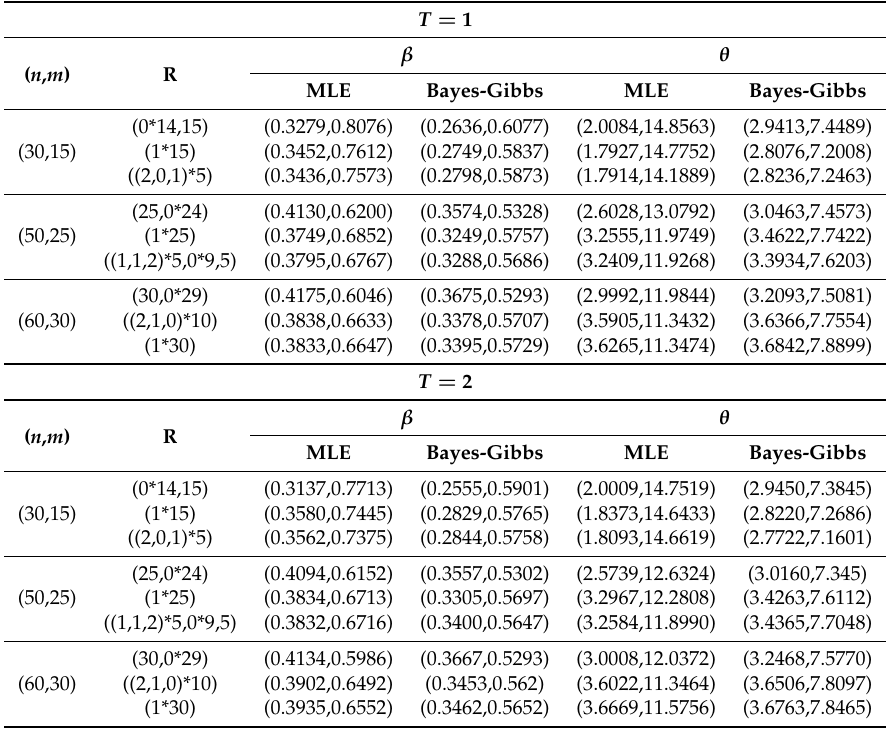
Table 6. The comparison of the average 95% intervals of maximum likelihood estimation (MLE) and Bayes-Gibbs method for ( 0.5,7 ) .